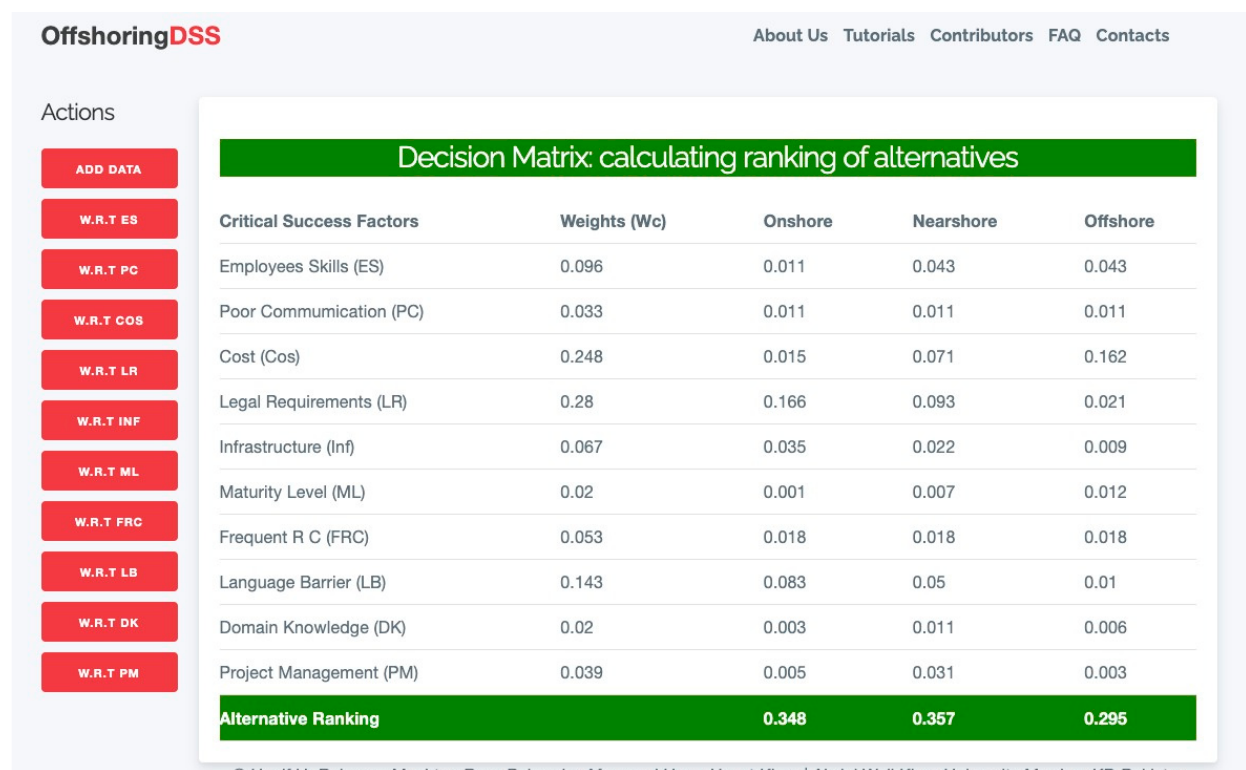
Figure 11. Ranking of sourcing alternatives.